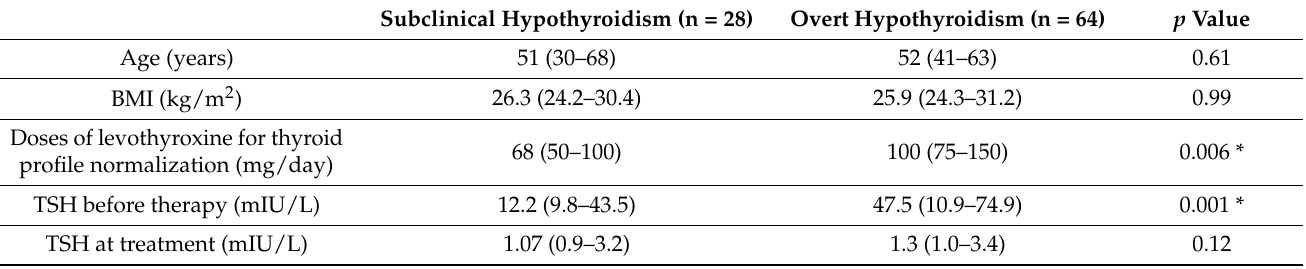
Table 3. Clinical and biochemical differences between subclinical and overt